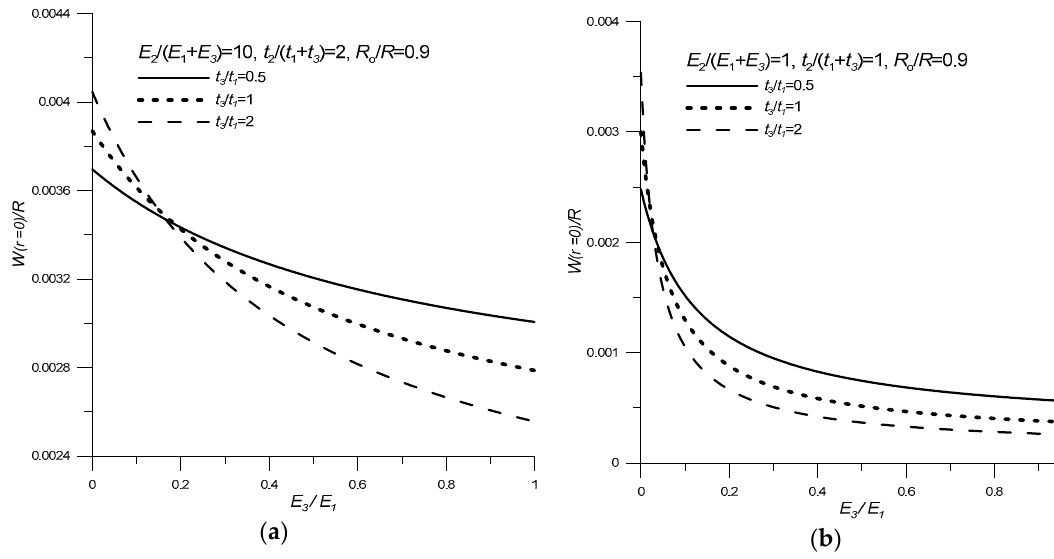
Figure 8. Influence of relative thickness and the ratio of elastic moduli of non-electrical materials on transducer deflection ( a ) E g = 10 , ( b ) E g = 1; ν 1 = 0.34, ν 3 = 0.46, R = 0.06m, R o / R = 0.9, V = 100 V.